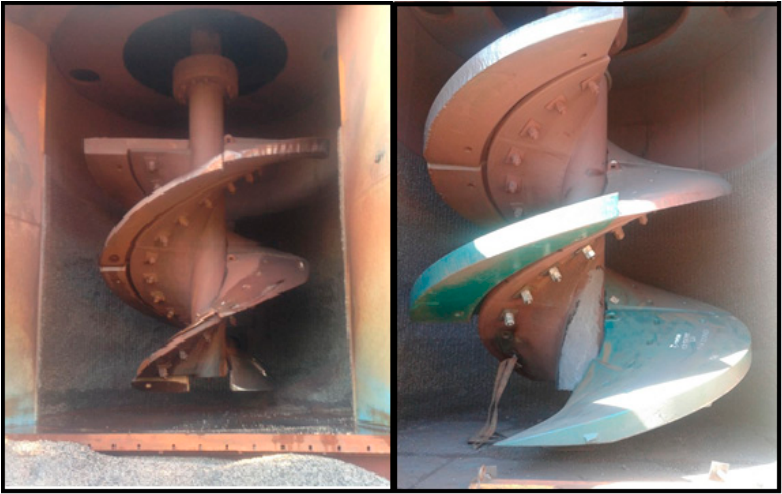
Figure 4. Left: Screw liner with intensive wear at the bottom. Right: New screw liner [6].